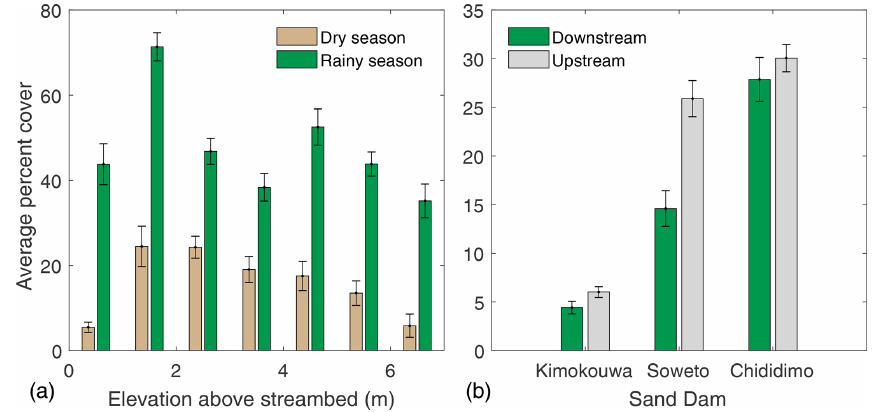
Figure 5. (a) Average percent cover at different elevations above the streambed for the dry and rainy seasons at the Soweto and Chididimo dams. Kimokouwa sand dam was excluded, because the sand dam is not functioning. Standard error bars are shown. (b) Average upstream and downstream vegetative cover at the three sand dams. Standard error bars are shown.